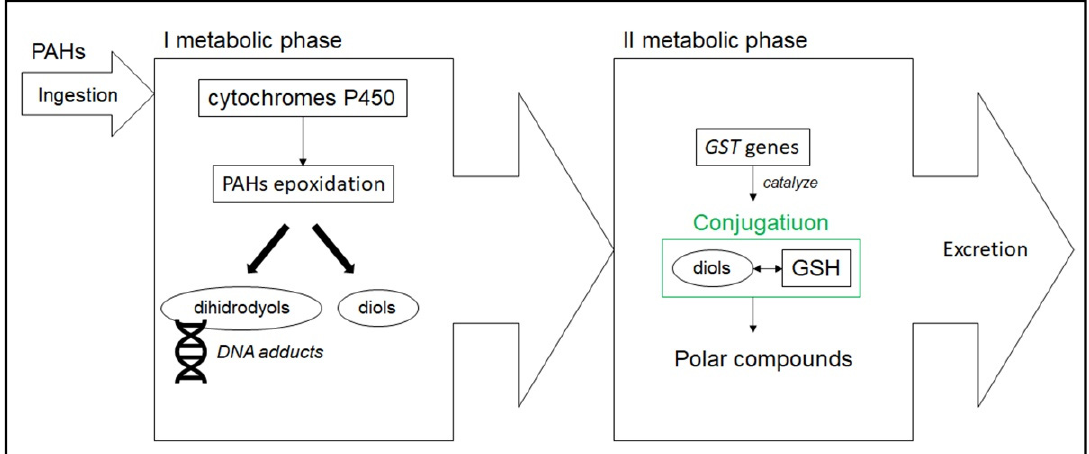
Figure 2. Schematic representation of the metabolic phases following PAHs ingestion. In the first phase, following ingestion or inhalation, PAHs are epoxidated by enzymes belonging to the cytochromes P450 family, with the formation of diols and dihydrodiols. Dihydrodiols can thus bind to the DNA, to give rise to DNA adducts. Then, in the second phase, the intermediate diols conjugate with glutathione, thanks to glutathione s-transferase enzymes. This leads to the formation of polar compounds, which can be easily excreted.